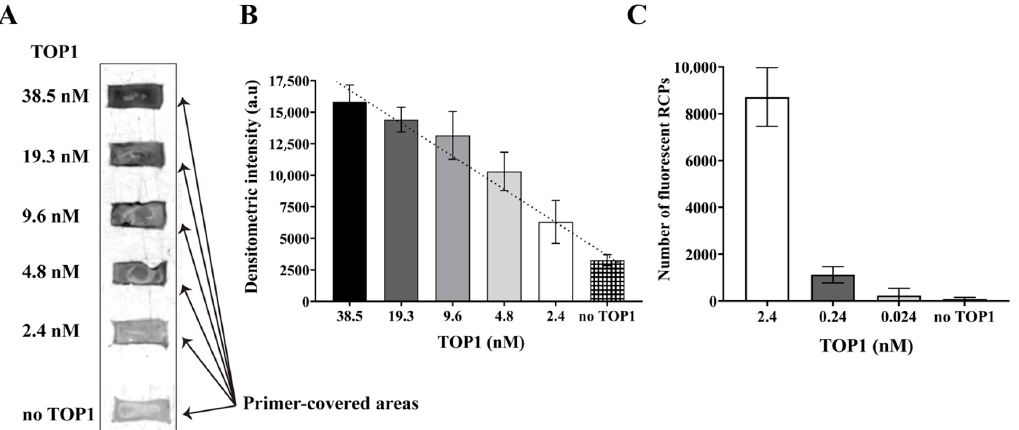
Figure 4. Silver-on-gold precipitation readout can be used for measuring TOP1 activity. ( A ) Scanned image obtained by the Bio-rad Geldoc of the REEAD-on-a-slide assay performed with serial dilutions of TOP1 and visualized using a silver-on-gold precipitation readout. The concentrations of TOP1 in each sample are indicated to the left. ( B ) Graphical depiction of a densitometric quantification of the scanned image shown in A. The data were plotted as average and error bars represent standard deviation of three independent experiments. a.u: arbitrary units. ( C ) Graphical depiction of the number of fluorescent RCPs obtained by measuring the activity of serial dilution of TOP1 by using the REEAD-on-a-slide. The data were plotted as average, and the error bars represent standard deviation of three independent experiments.